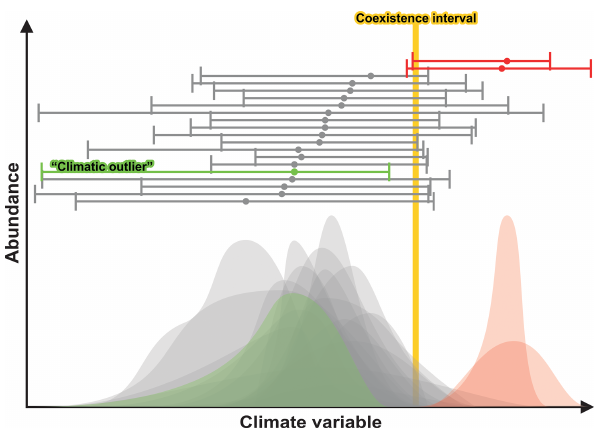
Figure 5. Climatic outliers and the bias of the Coexistence Ap- proach towards exotic nearest living relatives (NLRs). Shown are the niche response curves for 20 potential NLRs, of which 18 (grey and green) show a general overlap in their climatic preference. The two red NLRs are exotic elements with strongly differing climatic preferences. Bars indicate the minimum and maximum tolerances of each NLR; the dots highlight each NLR’s optimal climate value. Because the green NLR has no shared climate range with the two exotic NLRs (red), it would be excluded as a climatic outlier fol- lowing the Coexistence Approach protocol. The resultant coexis- tence interval (orange bar) is highly precise but reflects neither the climatic preference of the non-exotic (grey and green) nor exotic group of NLRs